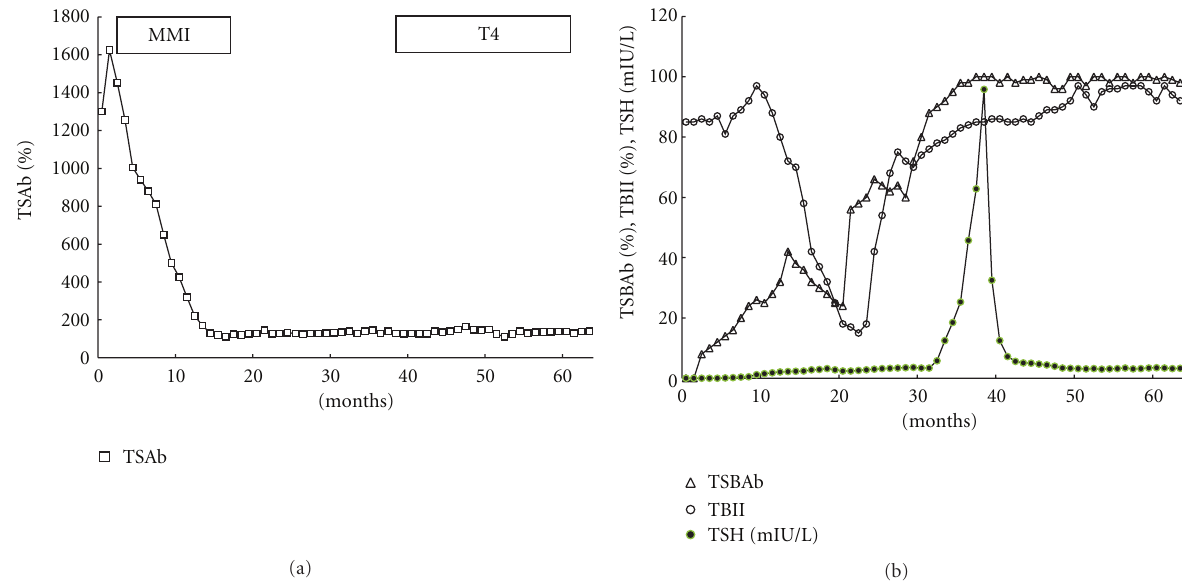
Figure 4: Clinical course of one of the 2 patients, who had TSAb-positive Graves’ hyperthyroidism and then developed TSBAb- positive hypothyroidism (Table 1, IId). A 40-year-old woman with TSAb-positive Graves’ hyperthyroidism developed TSBAb-positive hypothyroidism. She had TSAb-positive Graves’ hyperthyroidism ((a), (cid:2) ) with undetectable serum TSH ((b), • ) and then developed TSBAb- positive hypothyroidism ((b), (cid:4) ) with high serum TSH ((b), • ). TSAb was dominant initially ((a), (cid:2) ), and then TSBAb became dominant ((b), (cid:4) ). TBII ((b), ◦ ) reflects TSBAb- and TSAb-activity. A patient with TSAb-positive Graves’ hyperthyroidism developed TSBAb-positive hypothyroidism. She was treated with MMI and then with